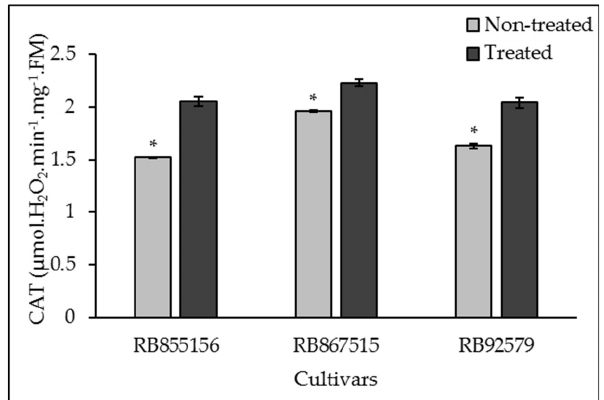
Figure 4. Activity of the catalase (CAT) enzyme in sugarcane plants treated with pyraclostrobin in relation to control plants. The results represent the average of six evaluation times and three replications. * Indicates a significant difference among treatments by the Tukey test at 5% probability. The bar indicates the standard error of the mean. FM: Fresh matter. Agronomy 2018 , 8 , x FOR PEER REVIEW